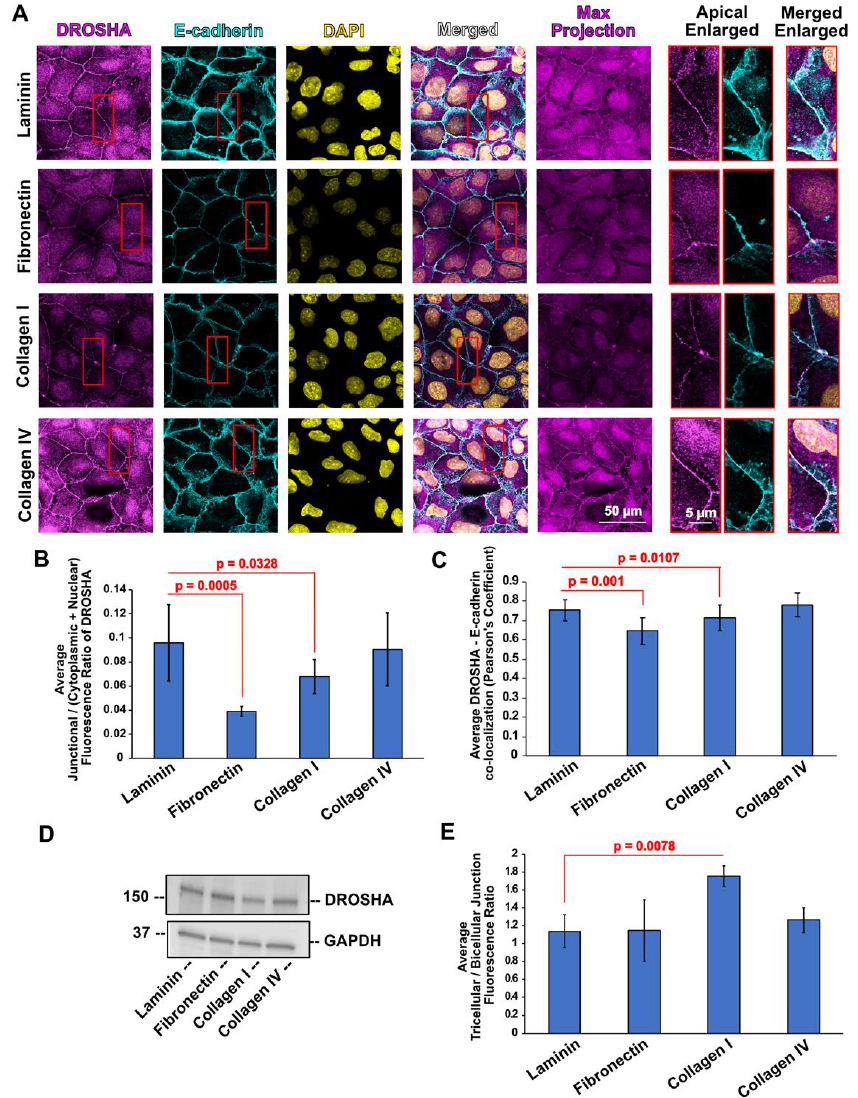
Figure 4. ( A ) Representative images of Caco2 colon epithelial cells plated on laminin, fibronectin, collagen I, and collagen IV stained by immunofluorescence for DROSHA (magenta), and E-cadherin (cyan). Nuclei were stained using DAPI (yellow). ( B ) Average junctional/(cytoplasmic + nuclear) fluorescence intensity ratios of DROSHA from cells plated on different ECM substrates. ( C ) Average co-localization of DROSHA with E-cadherin fluorescence from cells plated on different ECM sub- strates. ( D ) Western blot of Caco2 cells plated on different ECM substrates blotted for DROSHA; Actin is the loading control. ( E ) Average tricellular/bicellular fluorescence intensity ratios of DROSHA from Caco2 cells plated on different ECM substrates. Data were analyzed using a student t -test, where p < 0.05 and n = 27 or n = 12 ≤ n ≤ 30 for ( C ) (see also Methods, Section 2.5). Selected insets indicated in red boxes are shown enlarged on the right.